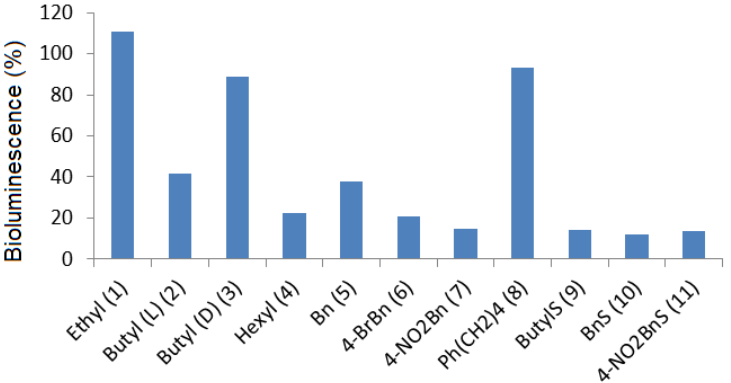
Figure 2. Antagonistic activity of carbamate and thiocarbamate analogues 1 – 11 : residual bioluminescence observed for all compounds at 100 µM. The luminescence was induced by OHHL at a concentration of 200 nM.